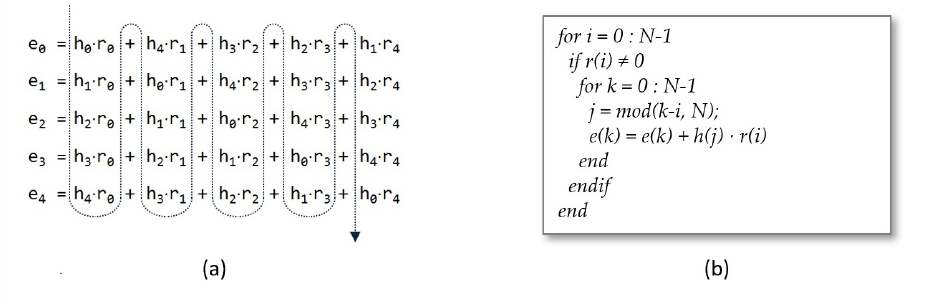
Figure 2. Evaluation of each term of the summation ( a ) and generation of indices i , j , and k ( b ) while sweeping the matrix by